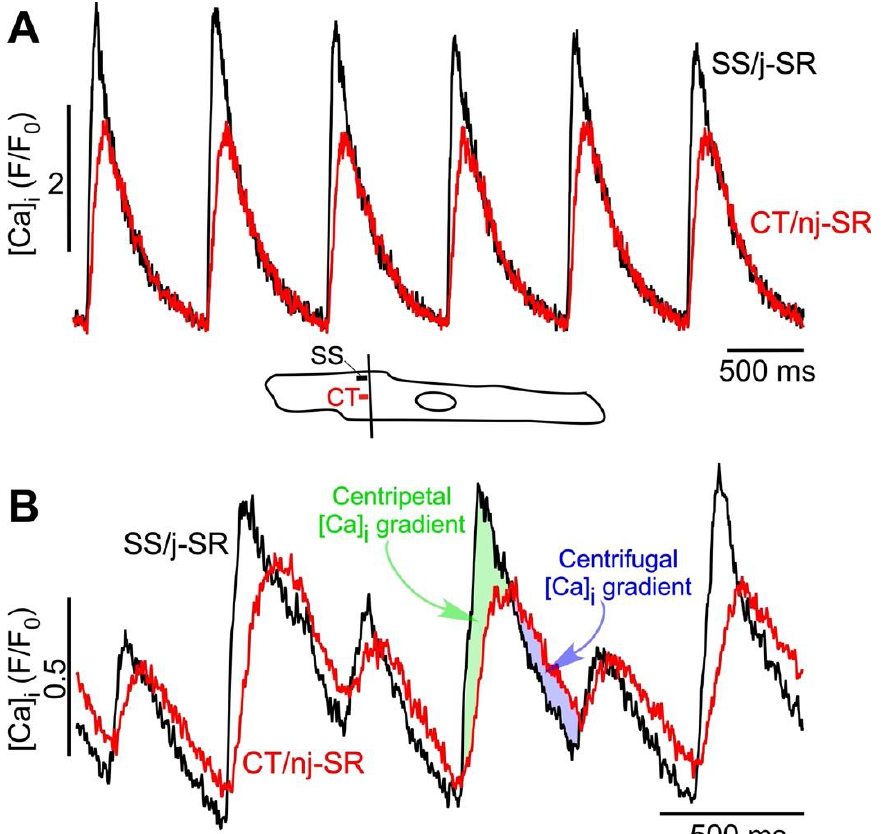
Figure 1. Atrial ECC and ‘ reverse FDUF ’ mechanism. ( A ) Subsarcolemmal (SS) Ca release from junctional SR (j-SR) and from central (CT) non-junctional SR (nj-SR) during electrical pacing at 1.3 Hz in the absence of CaT alternans. The Ca release from j-SR is faster and reaches a higher amplitude than nj-SR Ca release. CT [Ca] i never exceeds SS [Ca] i . Bottom: confocal scan line position and SS and CT regions of interest. Scan direction perpendicular to the longitudinal axis of the cell (transverse scan). ( B ) SS and CT Ca release during stable alternans. Alternans was induced by electrical